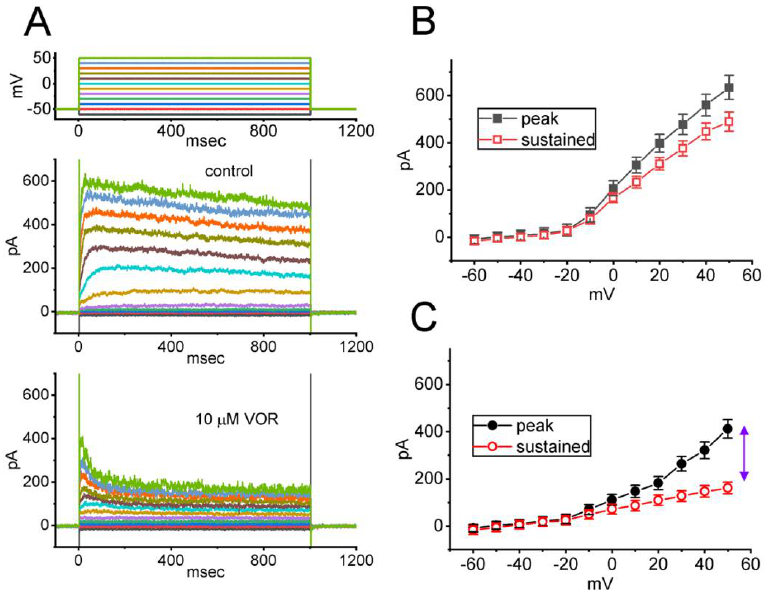
Figure 3. Mean current-voltage ( I-V ) relationship of the peak and sustained components of I K(DR) acquired with or without the VOR addition. The experiments were conducted in cells immersed in Ca 2+ -free Tyrode’s solution, and we filled up the electrode with K + -containing solution. ( A ) Representative current traces acquired in the absence (upper) and presence (lower) of 10 μM VOR. Voltage-clamp protocol that we used is illustrated in the uppermost part. In ( B , C ), the mean I-V relationships of the peak (filled black symbols) or sustained (open red symbols) component of I K(DR) were respectively taken in the control period (i.e., VOR was not present) and during exposure to 10 μM VOR. Each point represents the mean ± SEM (n = 8 for each point). The double arrowhead in the right side of ( C ) indicates the larger difference in current magnitude between peak and sustained components of I K(DR) in the presence of 10 μM VOR.